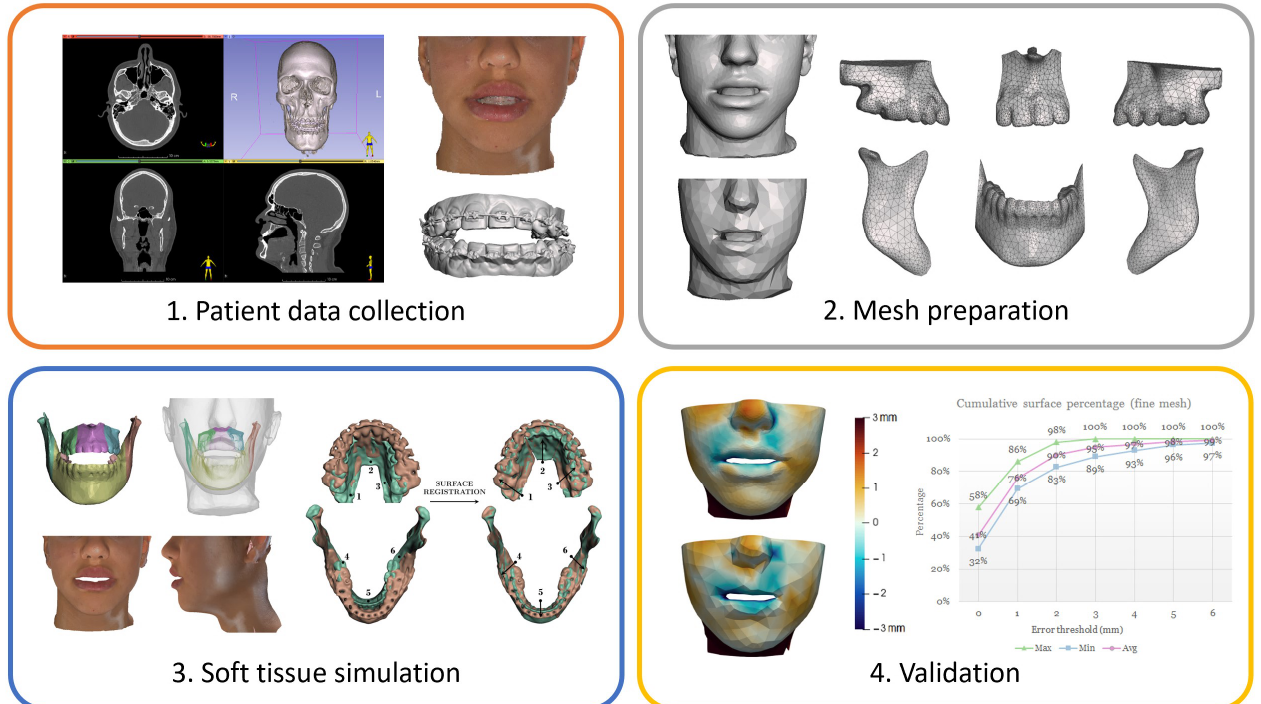
Figure 1. Scheme of the entire workflow presented in Alcañiz et al. [15] with the main steps: patient data collection ( left : CBCT image; top right: textured face 3D scan; bottom right: dental 3D scan), mesh preparation ( top left : soft tissue fine mesh; bottom left : soft tissue coarse mesh; right : bone fragments meshes), soft tissue simulation ( top left : boundary conditions; bottom left : textured simulation output; right : preoperative [green] and postoperative [brown] 3D models from CBCT scans before [left] and after [right] registration) and first quantitative validation ( top left : soft tissue simulation error for the fine mesh; bottom left : soft tissue simulation error for the coarse mesh; right : cumulative surface percentage plot for the fine